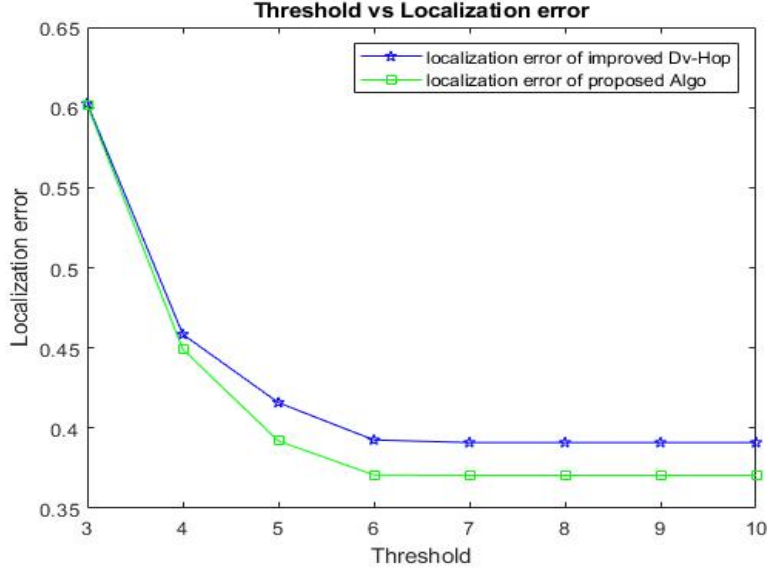
Figure 7. Comparison of threshold with/without using correction step.